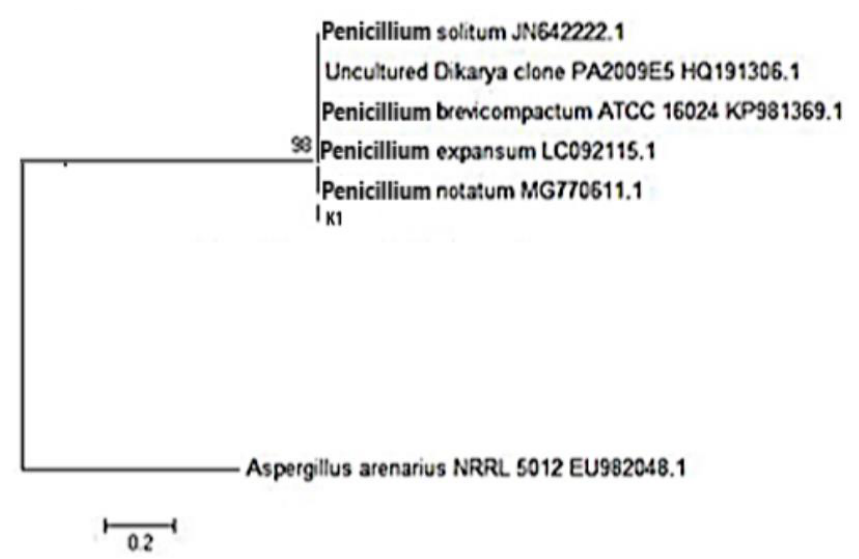
Figure 2. The phylogenetic tree of the fungal isolate, constructed using a neighbor-joining analysis of